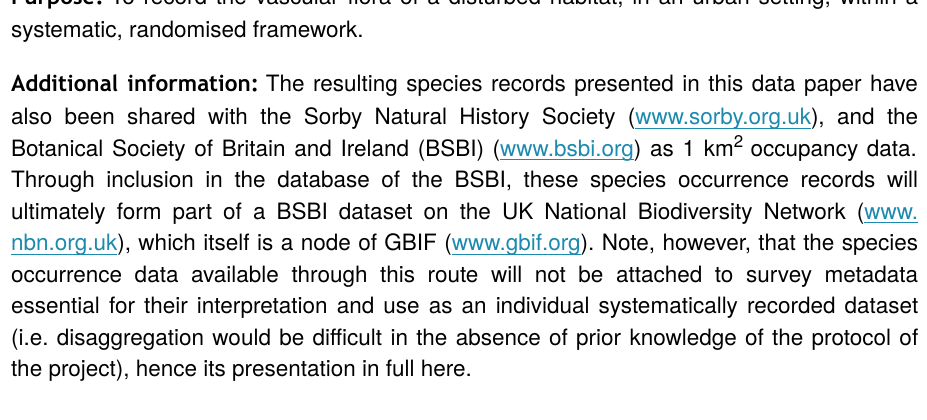
Sampling description: All 1 km grid cells of the British National grid (OSGB 1936 EPSG:27700) with at least 25% 'built-up' land cover in the Centre for Ecology &